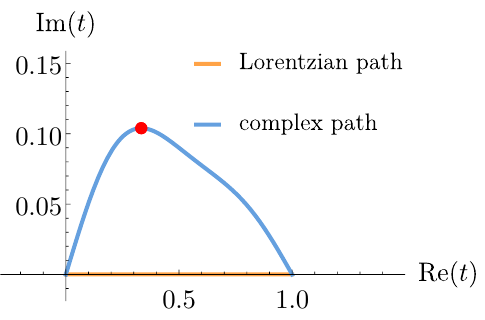
Figure 4 . Example of a smooth deformation of the time path between t 0 = 0 and t 1 = 1 in the complex plane. The point t ( u ? ) is plotted in red, where the tangent of the complex path is parallel to the real axis, and thus where Arg[ t 0 ( u ? )] = 0